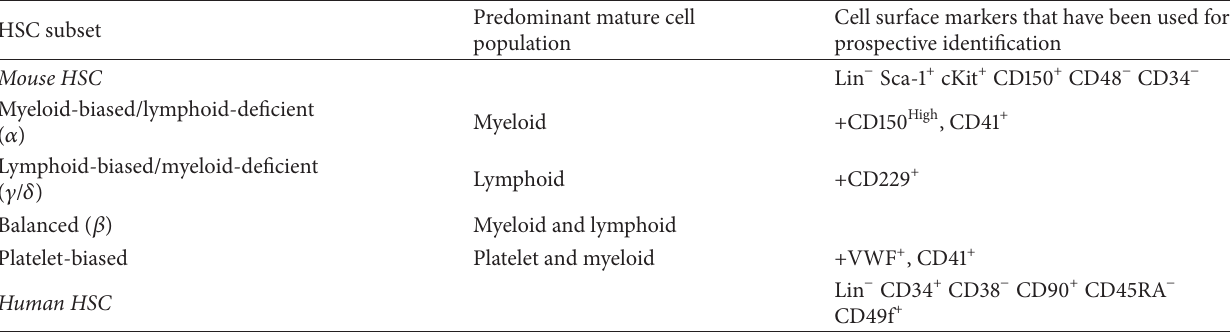
Table 1: Currently defined HSC subsets in mouse and their definition by mature cell output and cell surface markers. HSC